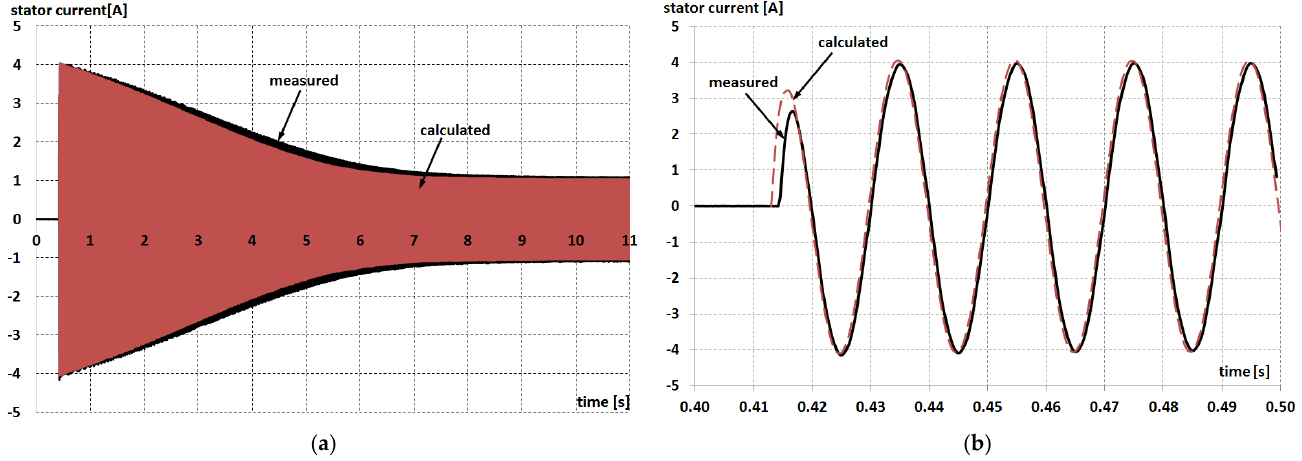
Figure 7. Measured and calculated time waveforms of the instantaneous value of the current in the stator phase winding during starting ( a ) and at the beginning of starting ( b ) when supplied from the mains with a voltage of 50 Hz, for the motor with additional inertia mass ( J = 0.00454 kg m 2 ).